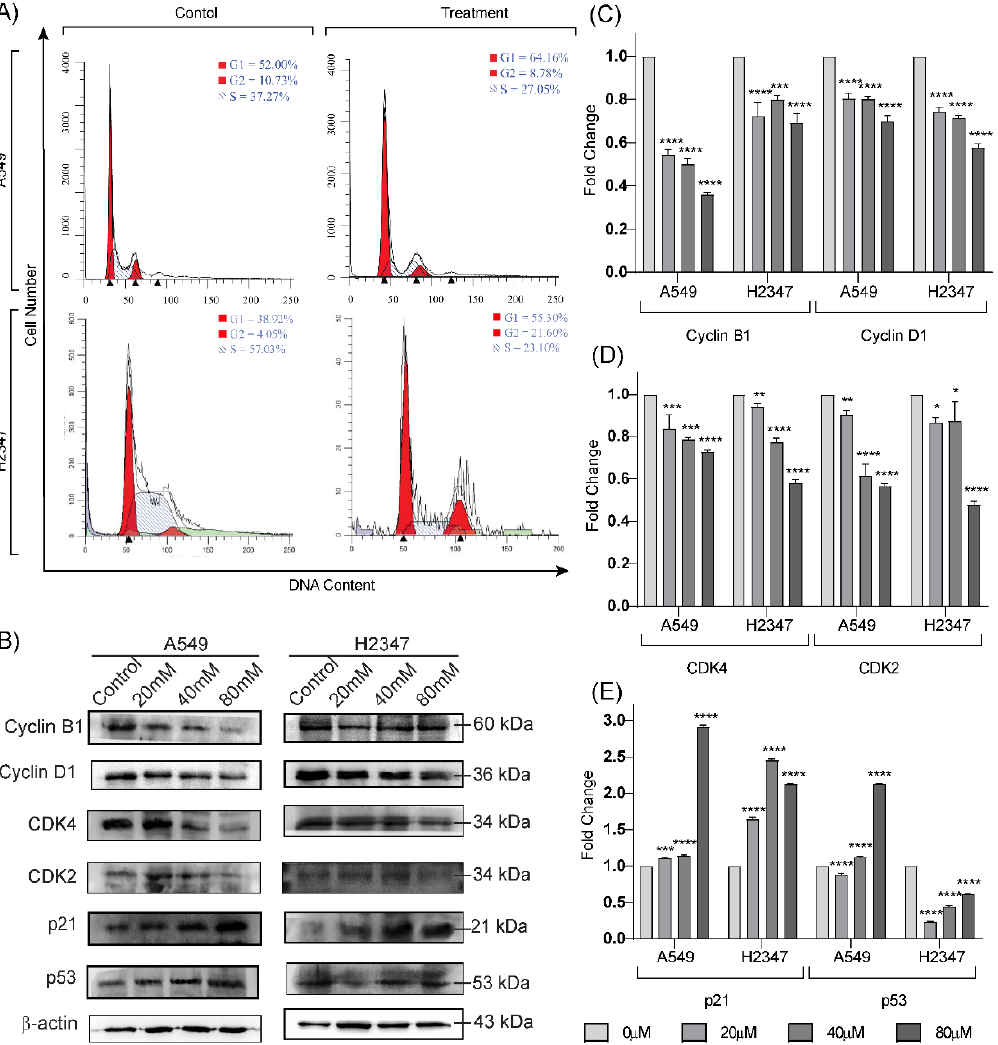
Figure 2. Lactucin and equivalent volume of vehicle (DMSO) exposure (24 h) induced cell cycle inhibition of lung adenocarcinoma A549 (80 µ M), and H2347 (70 µ M) cells ( A ) were measured by flow cytometry. WB analysis of cyclin B1, cyclin D1, CDK2, CDK4, p21, and p27 protein expression in A549 and H2347 cells after exposure to Lactucin at 0, 20, 40, and 80 µ M for 24 h ( B ). Lactucin significantly downregulates Cyclin B1 and Cyclin D1 ( C ), CDK4, and CDK2 ( D ) and downregulates the p21 and p53 ( E ) expression in both A549 and H2347 cells in a dose-dependent manner. Data are expressed as the means ± standard deviation of triplicate experiments. * p < 0.05, ** p < 0.01, *** p < 0.001, and **** p < 0.0001 were considered significant.